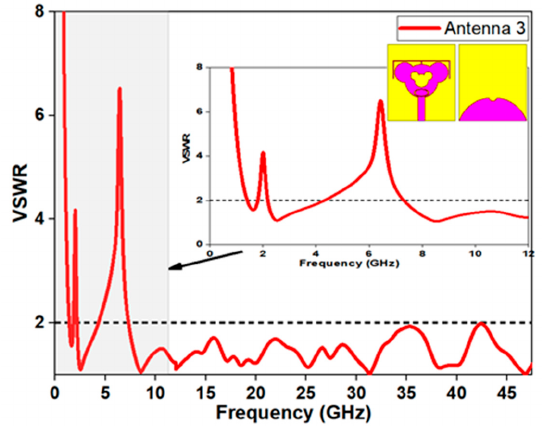
Figure 3. Phase 2: VSWR of the single band-notched antenna.